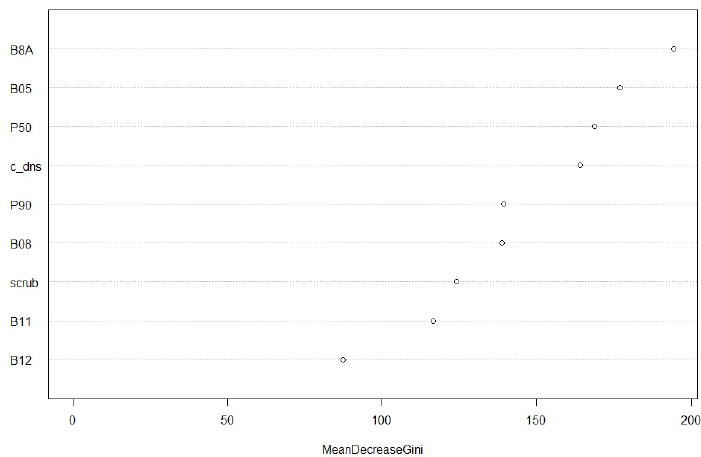
Figure 6. Plot of the Mean Decrease in Gini for each variable in Model 2.